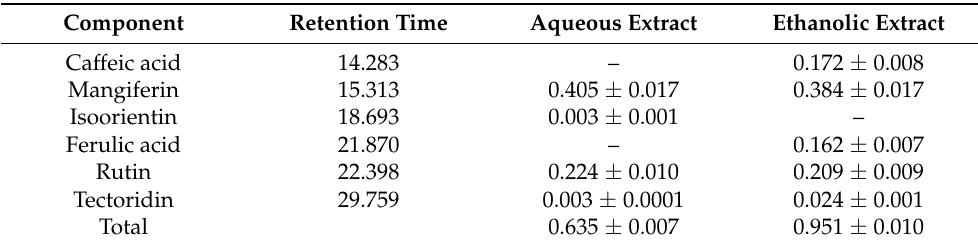
Table 4. The radical scavenging activity of individual compounds from C. sativus leaf extracts expressed as TEAC (mmol/L) using the ABTS post-column